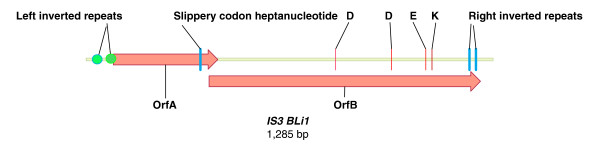
Schematic map of the insertion sequence IS3Bli1. Nine identical copies of this 1,285-bp element were found in the genome of B. licheniformis ATCC 14580. Features of the IS3Bli1 element are summarized in the text.